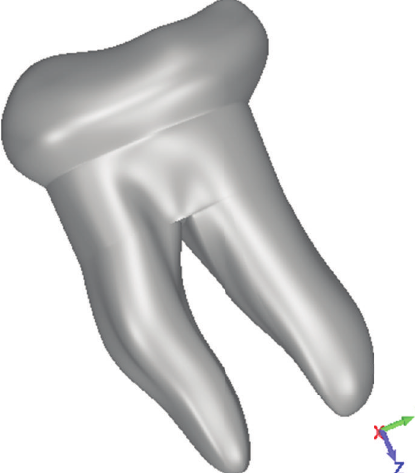
Figure 3: Parametric model of a mandibular